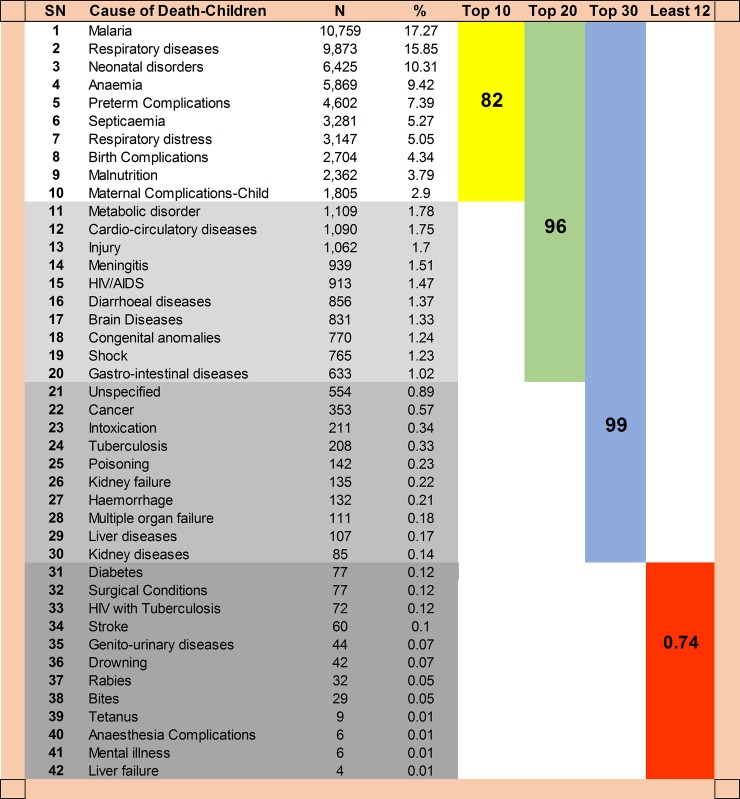
Cumulative proportion of death by cause of death groups among children < 5 years old.